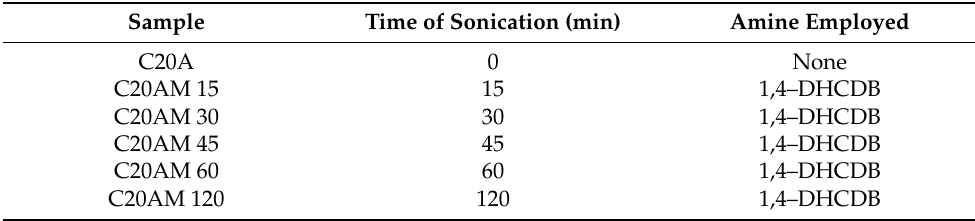
Table 1. Identification of the samples according to treatment time.